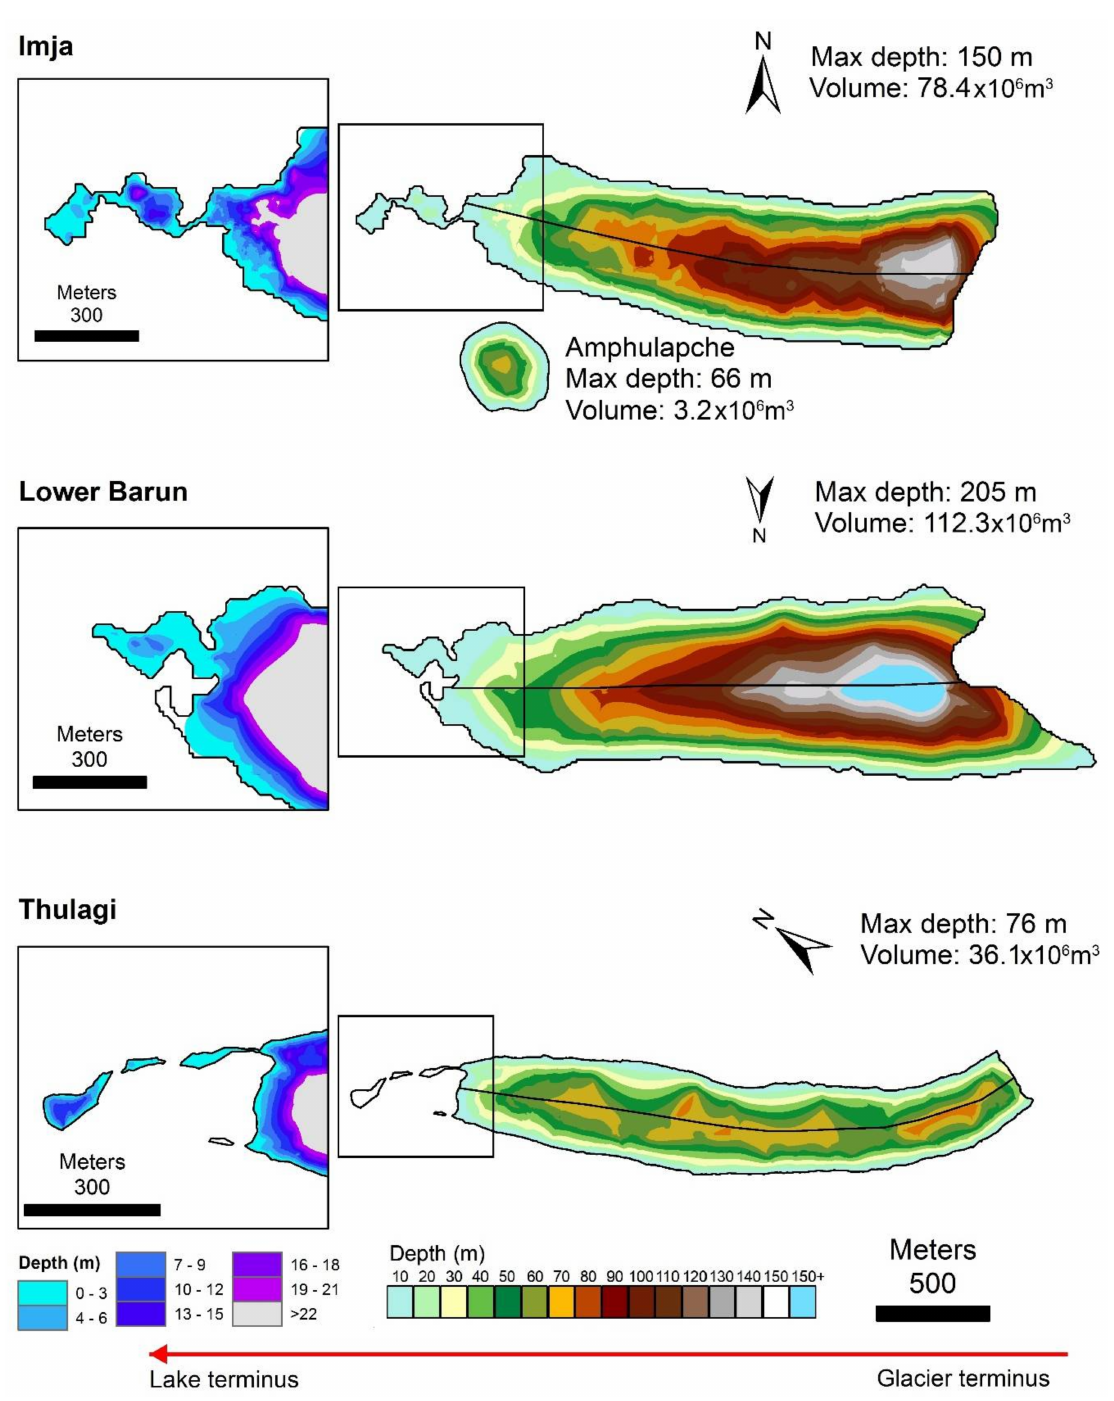
Figure 9. Smoothed bathymetric map of all three lakes. Inset shows the lake terminus